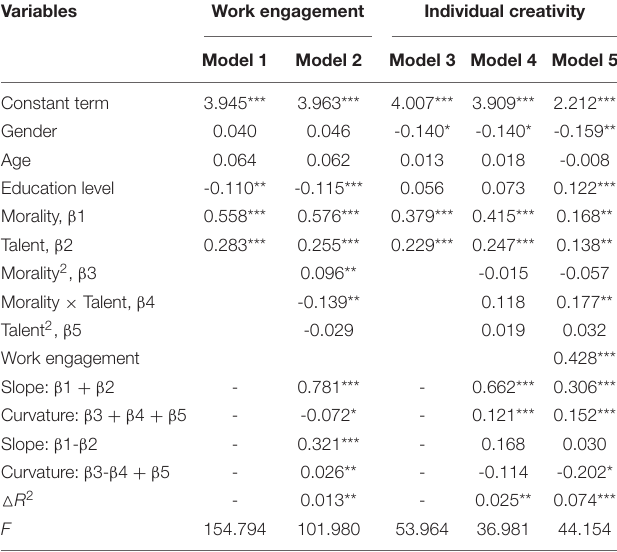
TABLE 2 | Polynomial regression